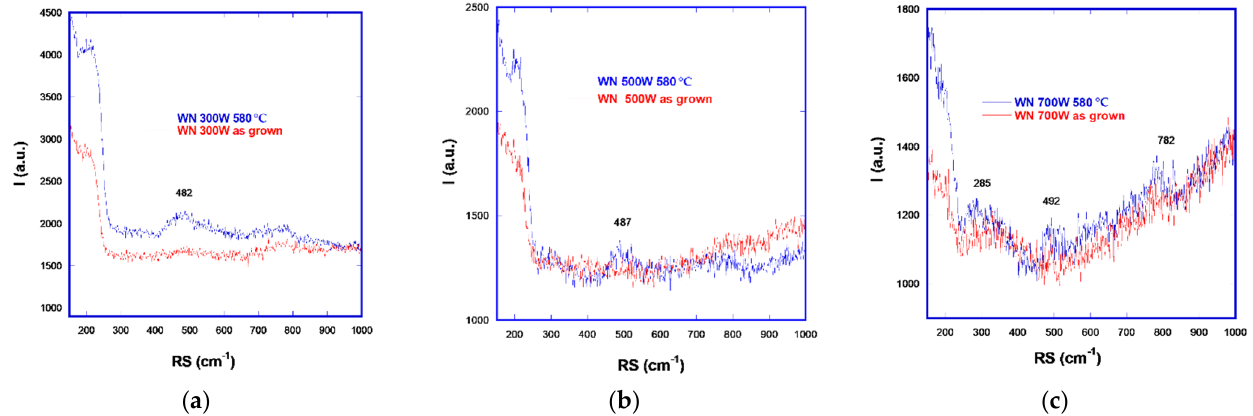
Figure 7. Micro ‐ Raman before (red line) and after (blue line) annealing at 580 °C for 300 W ( a ), 500 Figure 7. Micro-Raman before (red line) and after (blue line) annealing at 580 ◦ C for 300 W ( a ), 500 W W ( b ), 700 W ( c ). ( b ), 700 W ( c